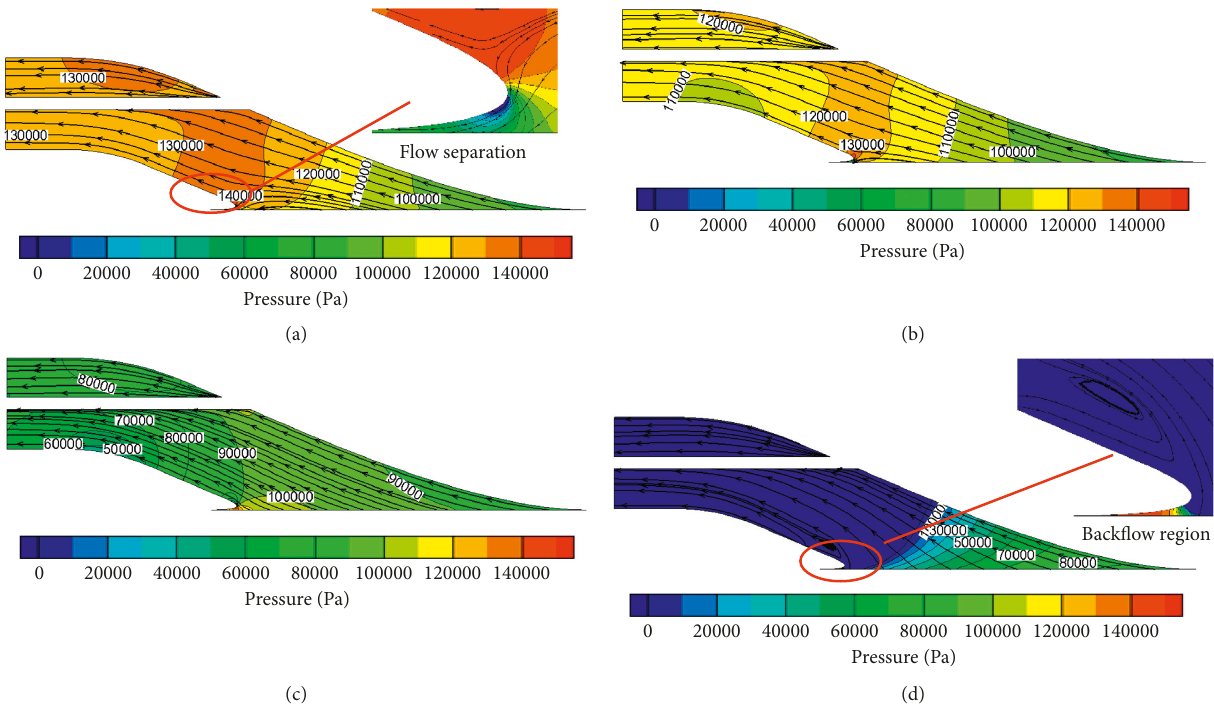
Figure 11: Pressure contour and streamlines in the inlet passage with different IVRs. (a) 0.54, (b) 0.67, (c) 0.94, and (d) 2.38.